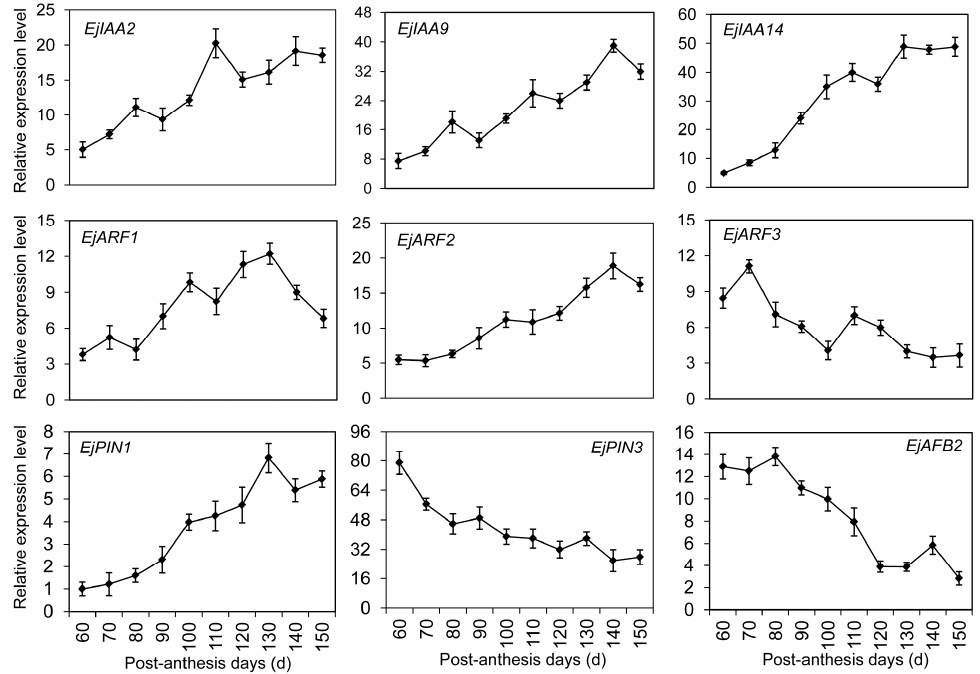
Figure 6. Expression profiles of differentially expressed genes DEGs involved in the auxin signal pathway using qRT-PCR. Each point is the mean of three determinations. Vertical bars, if larger than symbols, represent the standard error of the mean ( n = 3).